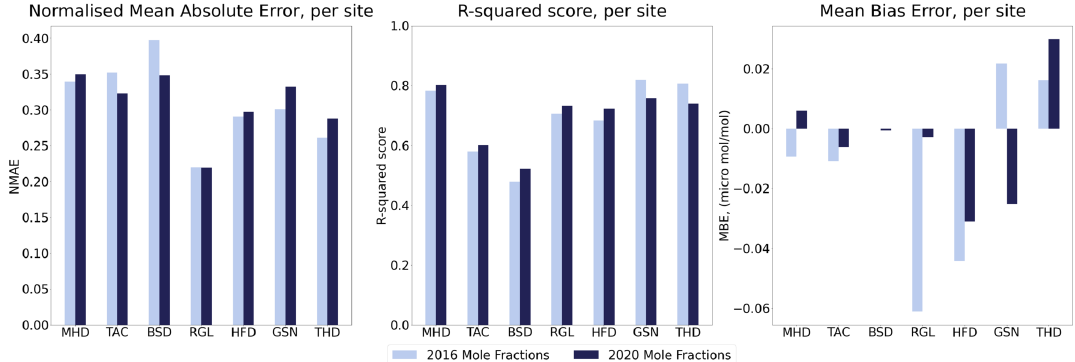
Figure 5. Evaluation of emulators with mole fraction comparison, using metrics NMAE, R -squared score, and MBE, shown per site and year.